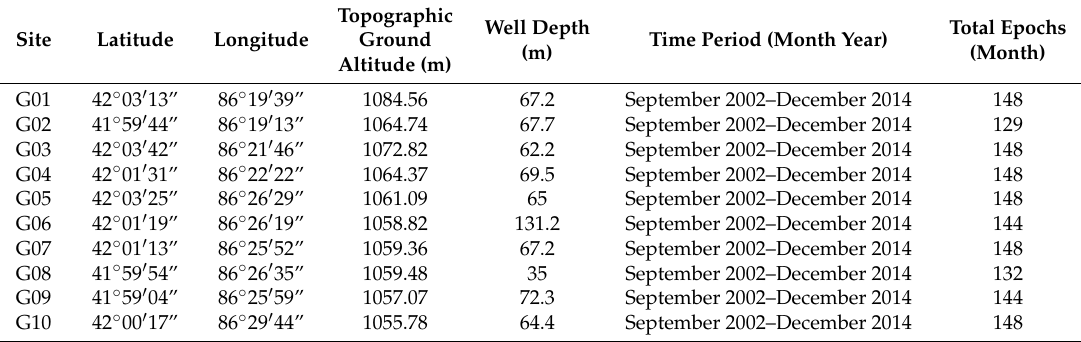
Table 1. Geographical characteristics of the observation wells and the sampled